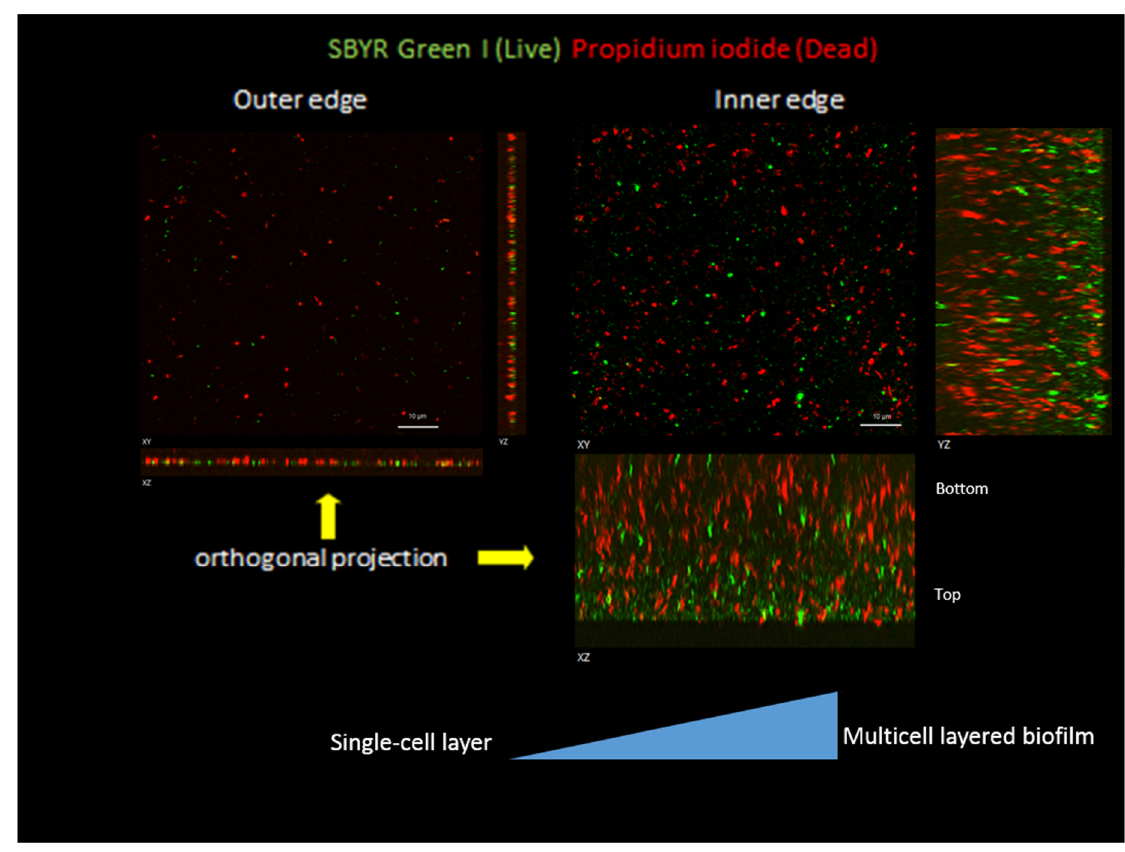
Figure 3. Images of M. algicola DG893 intercolony film on a thin layer of 0.3% agar, observed under fluorescence microscopy using SYBR Green I (green) and propidium iodide (red) visualized by FITC and TRITC filters to detect cell viability. Scale bar: 10 μ m.